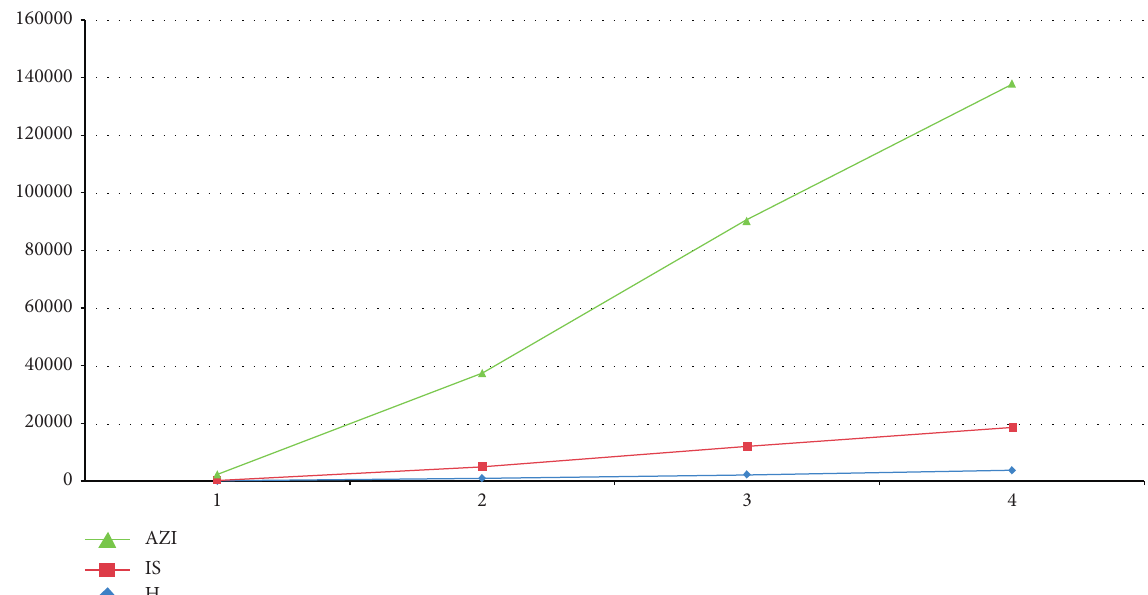
Figure 5: Graphical comparison between H ( Γ HC